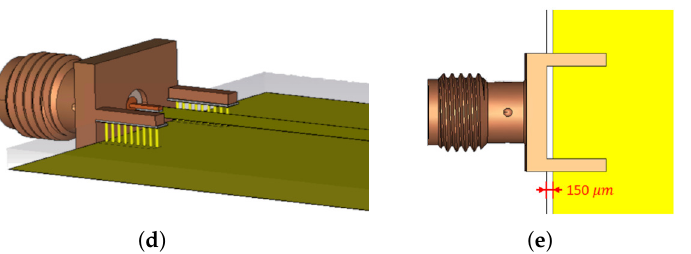
Figure 3. 3D models to investigate increased insertion and transmission losses at an SMA-to- microstrip interface. ( a ) PCB 1 model with ground metal at the top layer (no vias). ( b ) PCB 2 model with increased length of top ground metal (no vias). ( c ) PCB 3 with removed ground metal at the top layer. ( d ) PCB 4 with vias to connect the top and bottom ground. ( e ) bottom view of PCB designs ( a – d ). All PBC designs use the same SMA connector model [3].